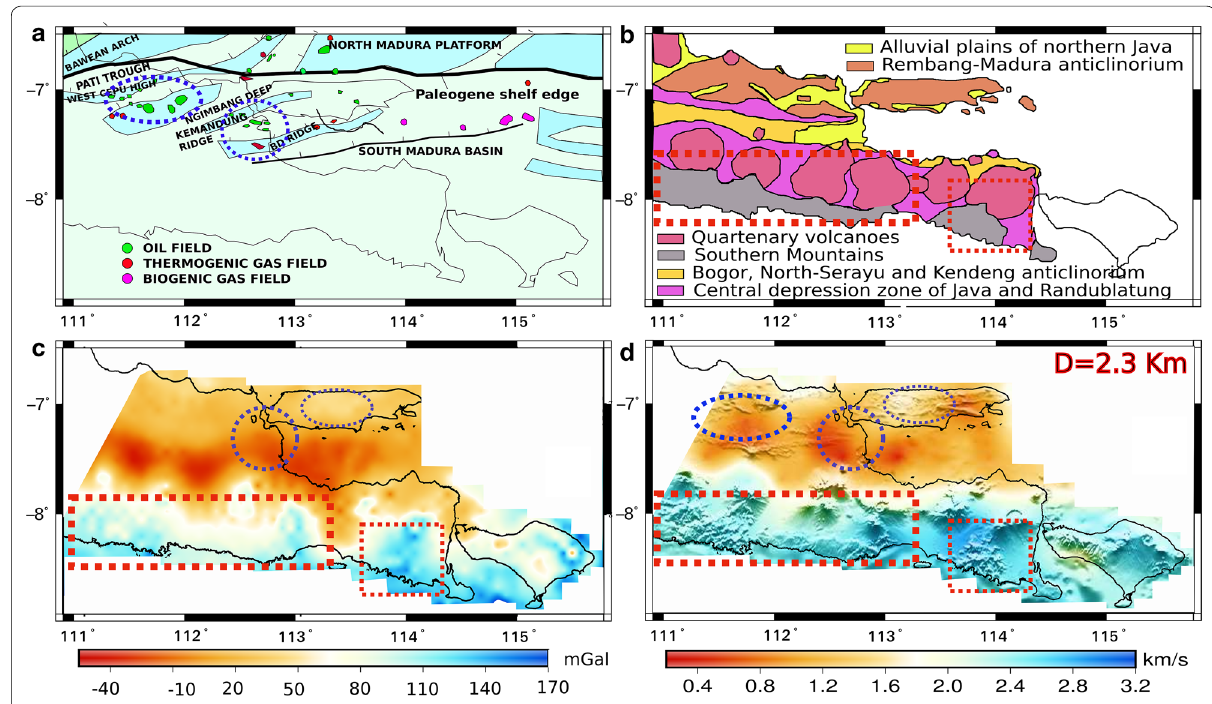
Fig. 11 a Paleogene paleogeography of East Java basin [modified from Satyana and Purwaningsih (2002)]. b Physiography map [modified from Bemmelen (1949)]. c Bouguer Anomaly of East Java and Bali area. d Shear wave velocity at 2.3 km depth. Shapes ( squares and circles ) indicate the similarity of